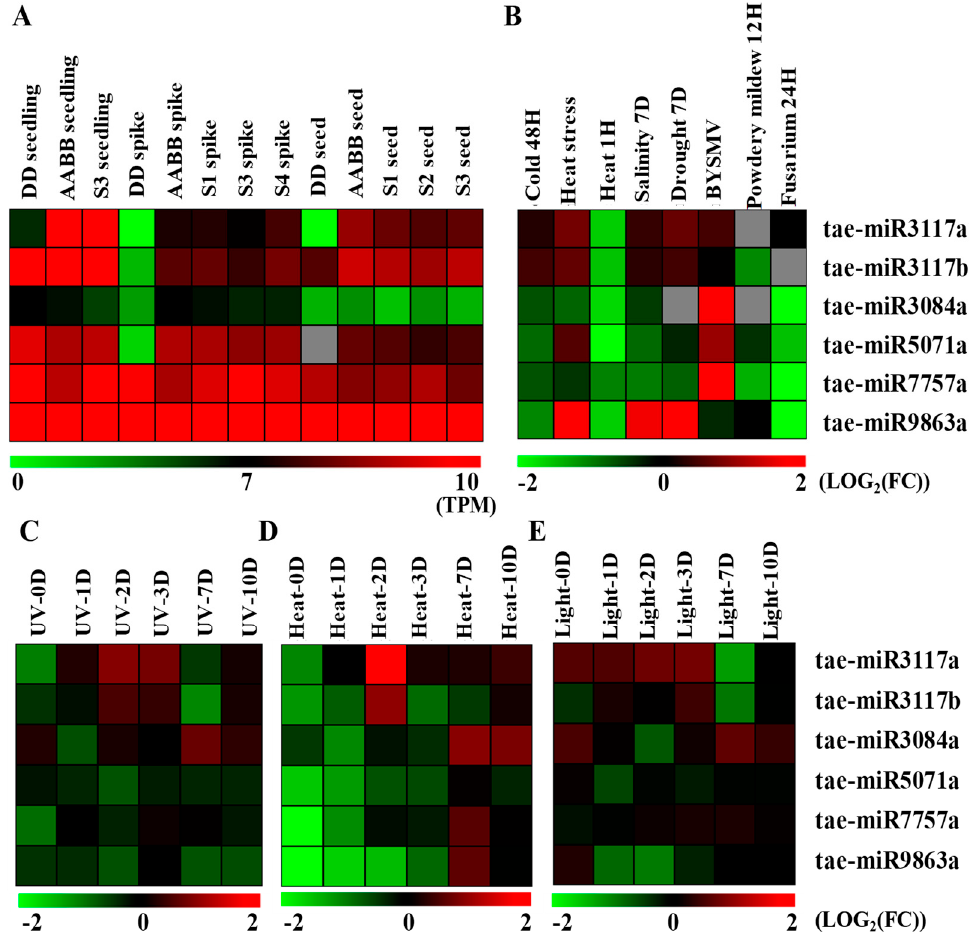
Figure 2. ( A ) The expression profiles of disease resistance-associated miRNAs in Triticum including diploid (AA and DD), tetraploid (AABB) and hexaploid (AABBDD including S1, S2, S3, and S4) wheat. ( B–E ) The expression responses of disease resistance-associated miRNAs under biotic stresses including BYSMV , powdery mildew, and Fusarium and abiotic stresses including cold, heat, salinity, drought, UV, and light. The gray color is the absence of an expression value.